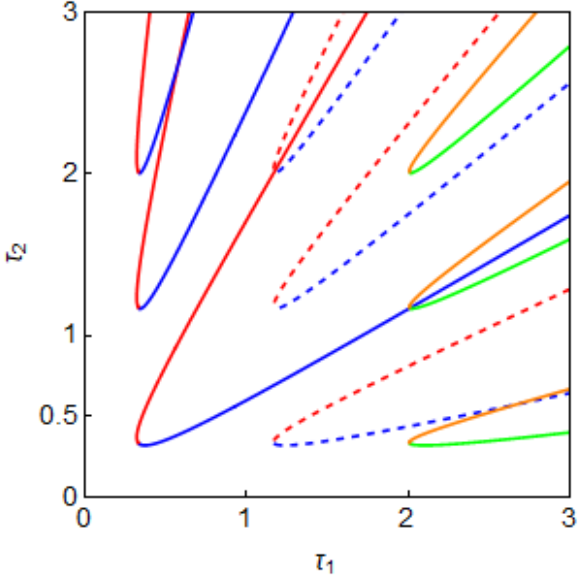
Figure 1. The stability switching curves